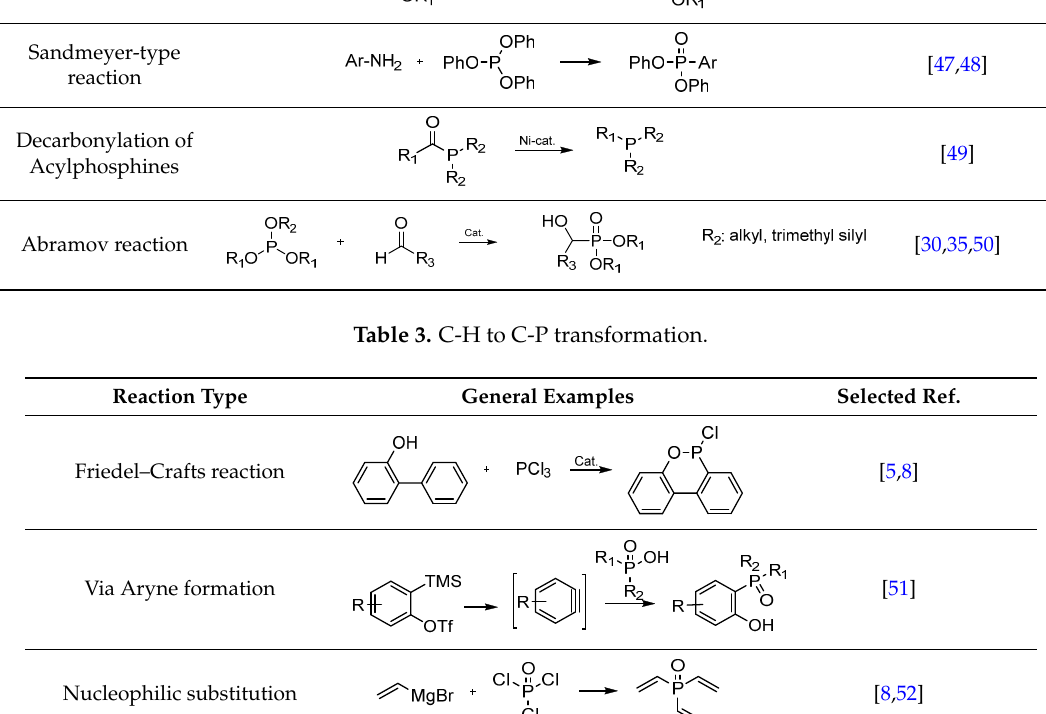
Selected Ref. Selected Ref.